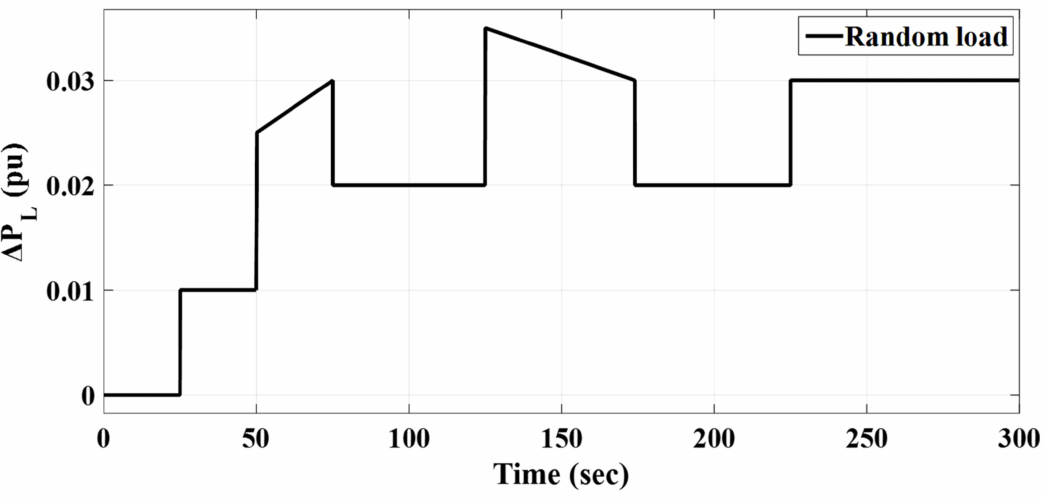
Figure 25. The form of the applied